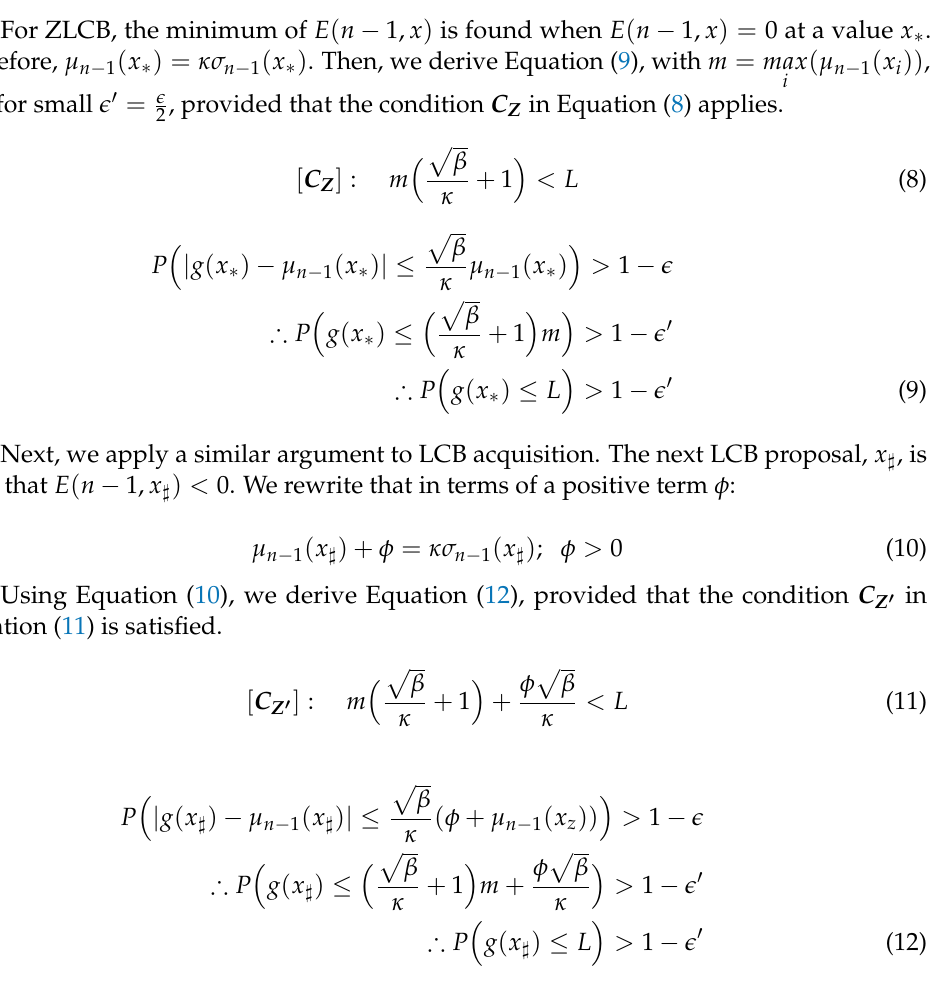
Figure 1. E ( n − 1, x ) in the interval I for ZLCB and LCB, showing minimum value next proposals x ∗ and x (cid:93) , respectively.